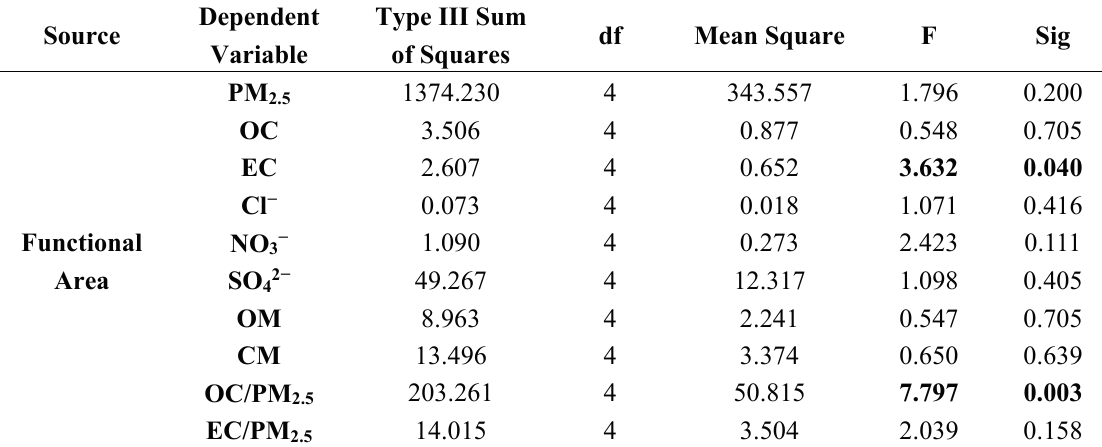
Table 5. Results of the GLM applied to PM 2.5 and its chemical components (tests of between-subjects effects) for the five functional areas in Xiamen.